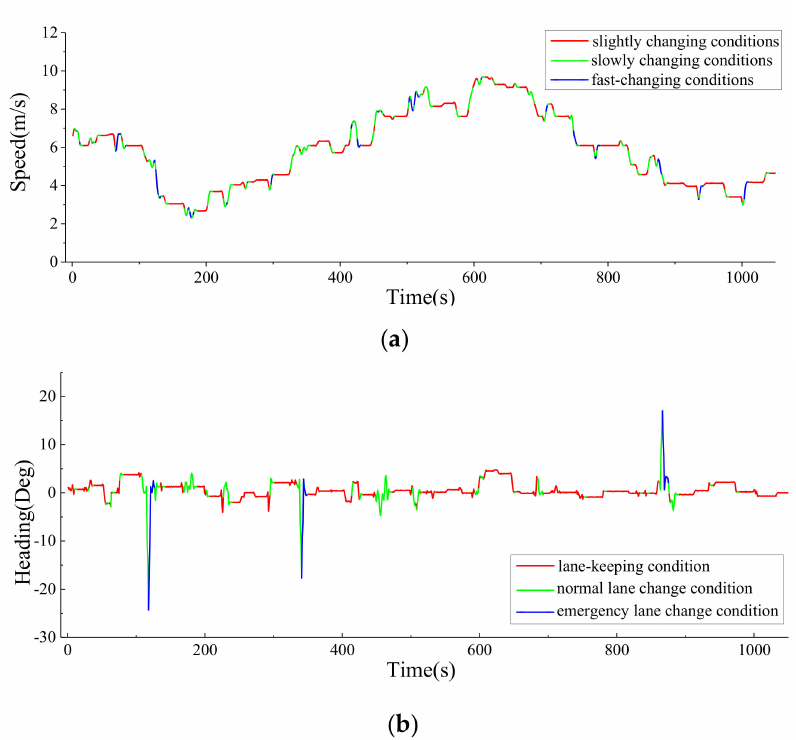
Figure 2. Driving intent classification results: ( a ) vertical driving intention classification results; ( b ) horizontal driving intention classification